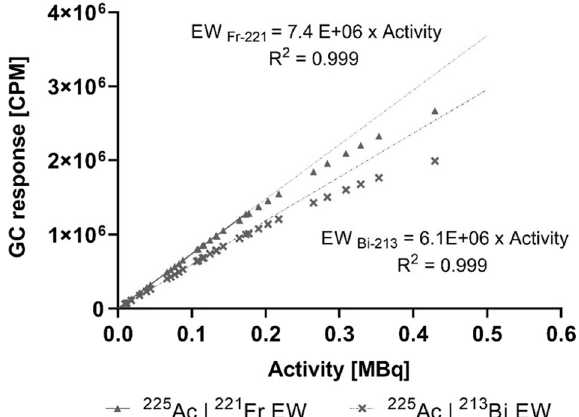
Fig. 3 GC response for 225 Ac in SEq with 221 Fr and 213 Bi, measured with both EWs of 221 Fr and 213 Bi. Error bars represent the standard deviation provided by the GC software